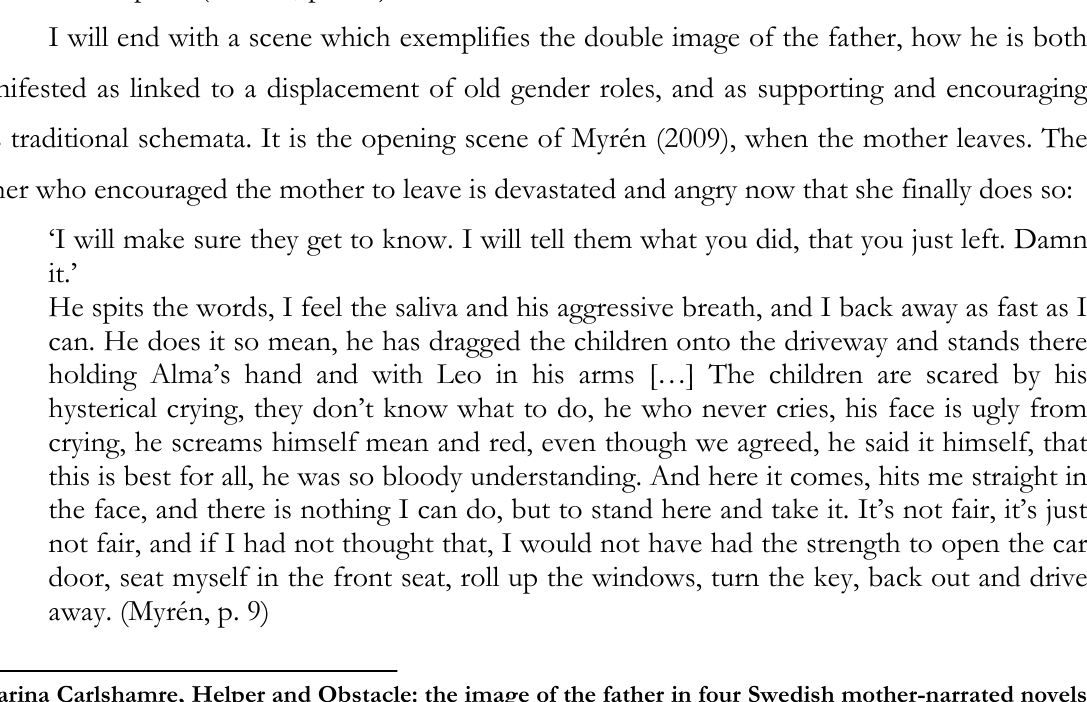
Katarina Carlshamre, Helper and Obstacle: the image of the father in four Swedish mother-narrated novels of the early 21 st Century: Myrén, Nordin, Sandberg and Sveland Studies in the Maternal , 5(2), 2013,